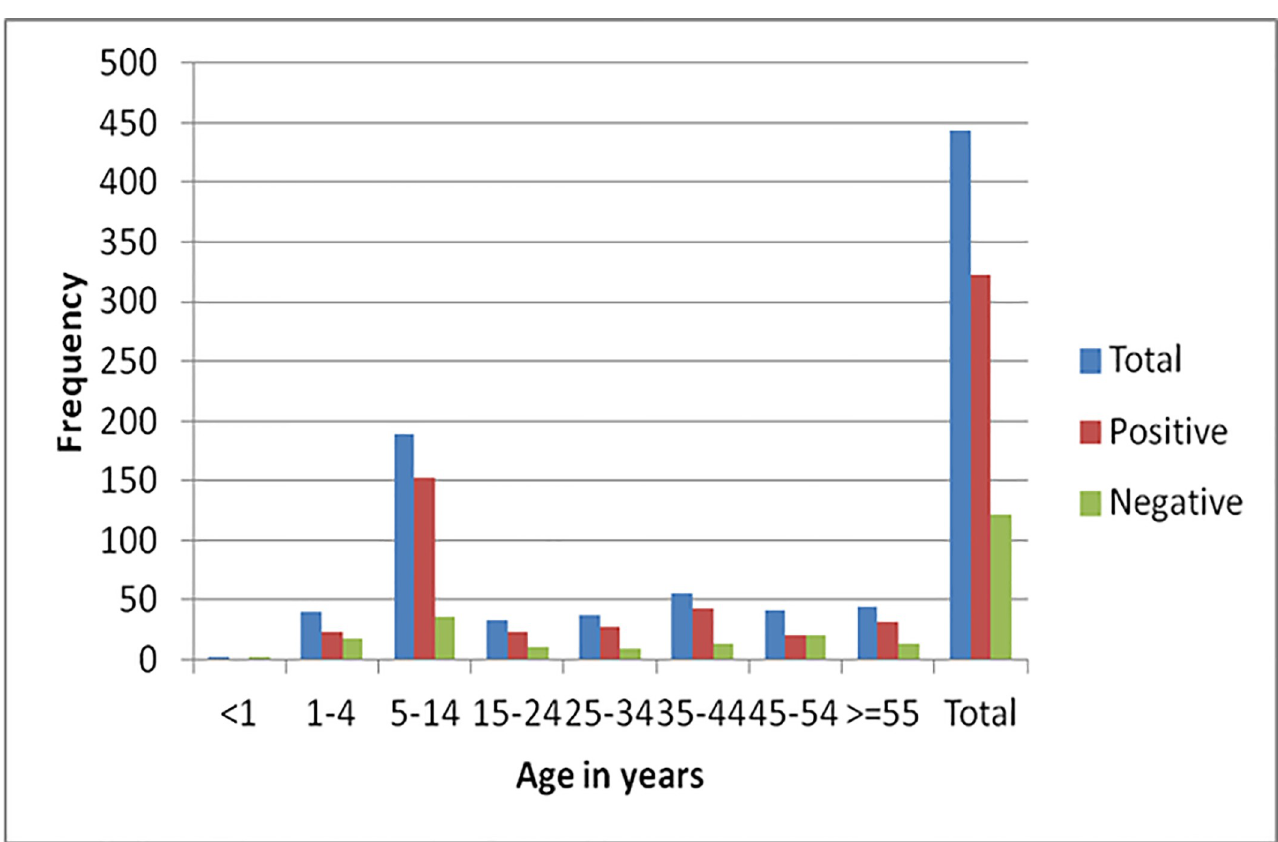
Fig 4. Age specific prevalence of intestinal parasites among populations from three islands of Lake Ziway, Oromia Region, Ethiopia, 2013 (n = 444).